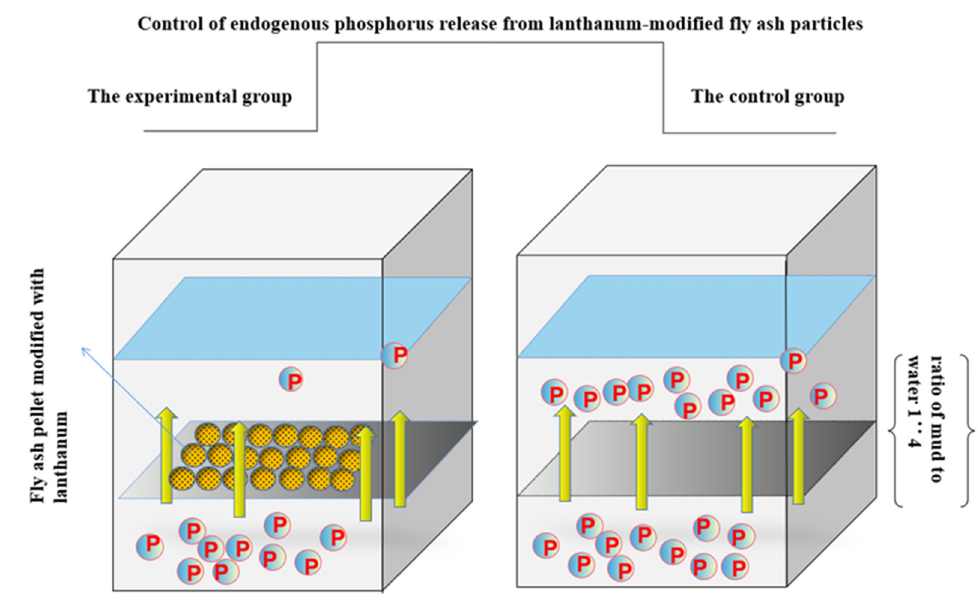
Figure 2. Schematic diagram of the simulated experimental setup.